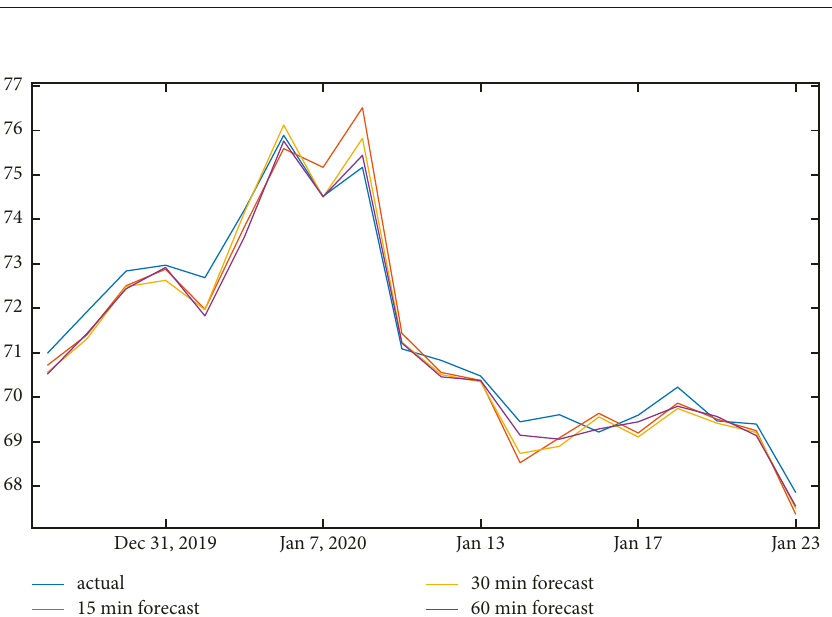
Figure 5: Actual and forecast price (USD per barrel) in different frequencies with night trading (before February, 2020).